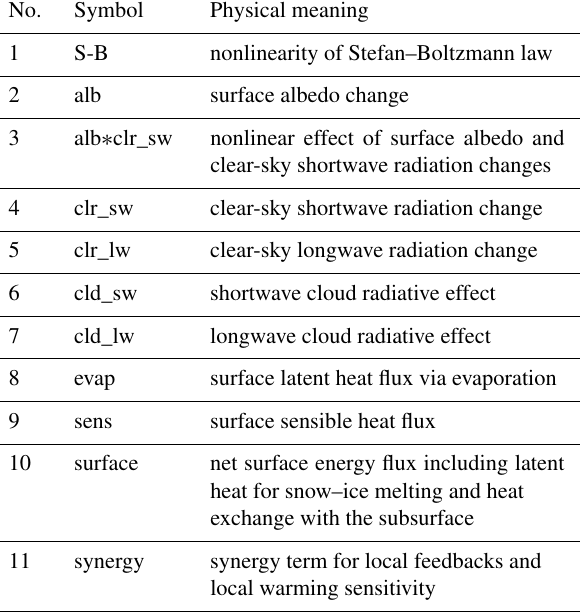
Table 3. List of the energy flux terms used in Fig. 16. Row 1 repre- sents the strength of the global mean feedback calculated with local warming sensitivity reproduced from Yoshimori and Suzuki (2019). Rows 2–10 represent the strength of local feedback calculated with global mean warming